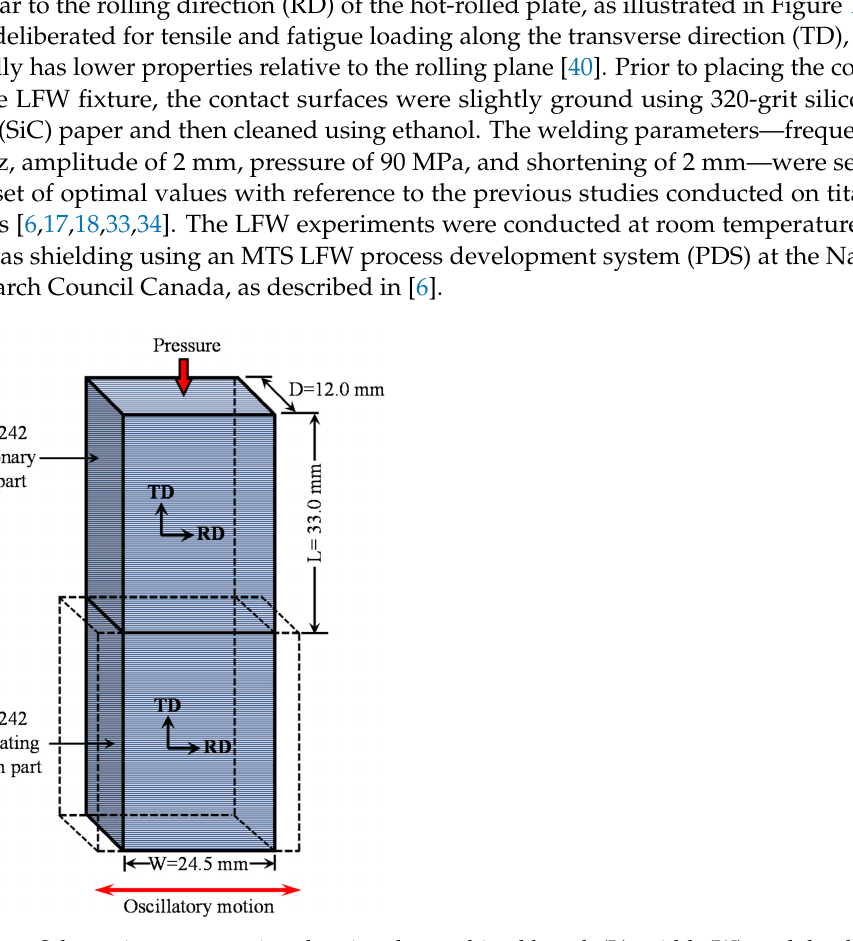
Figure 1. Schematic representation showing the machined length (L), width (W), and depth (D) of the Ti-6242 coupons (tolerance of 0.02 mm) with the rolling direction (RD) and transverse direction (TD) orientations